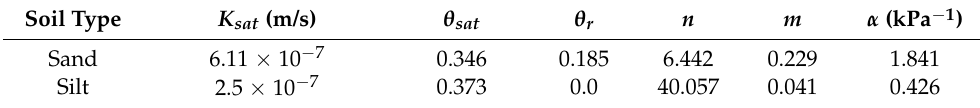
Table 6. Hydraulic properties of the materials in Section 4.2.